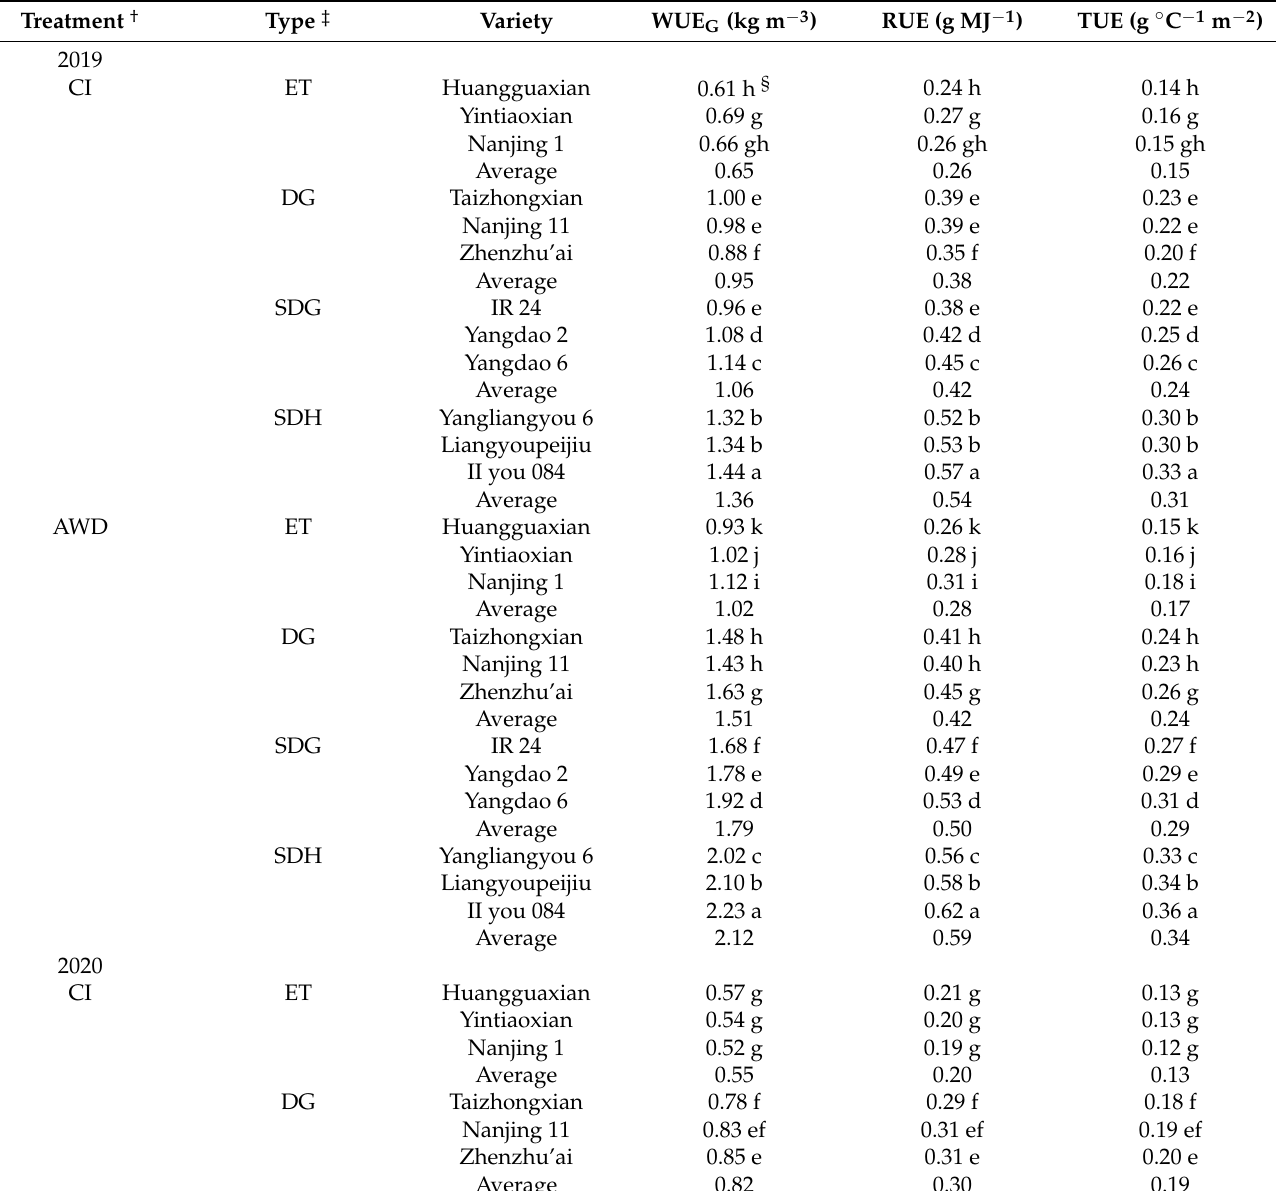
Table 4. Effect of irrigation on grain yield-level water use efficiency (WUE G ), radiation use efficiency (RUE), and temperature use efficiency (TUE) of mid-season indica rice genotypes during the 2019 and 2020 growing